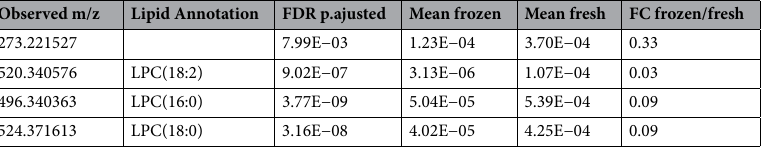
Table 4. Differentially expressed lipids between fresh and frozen in vitro produced embryos. Features with fold-change (FC) > 1.5 or < 0.66 are presented here. p value with FDR (false discovery rate) is presented here. The complete table with lipid annotations is provided in Supplementary Table